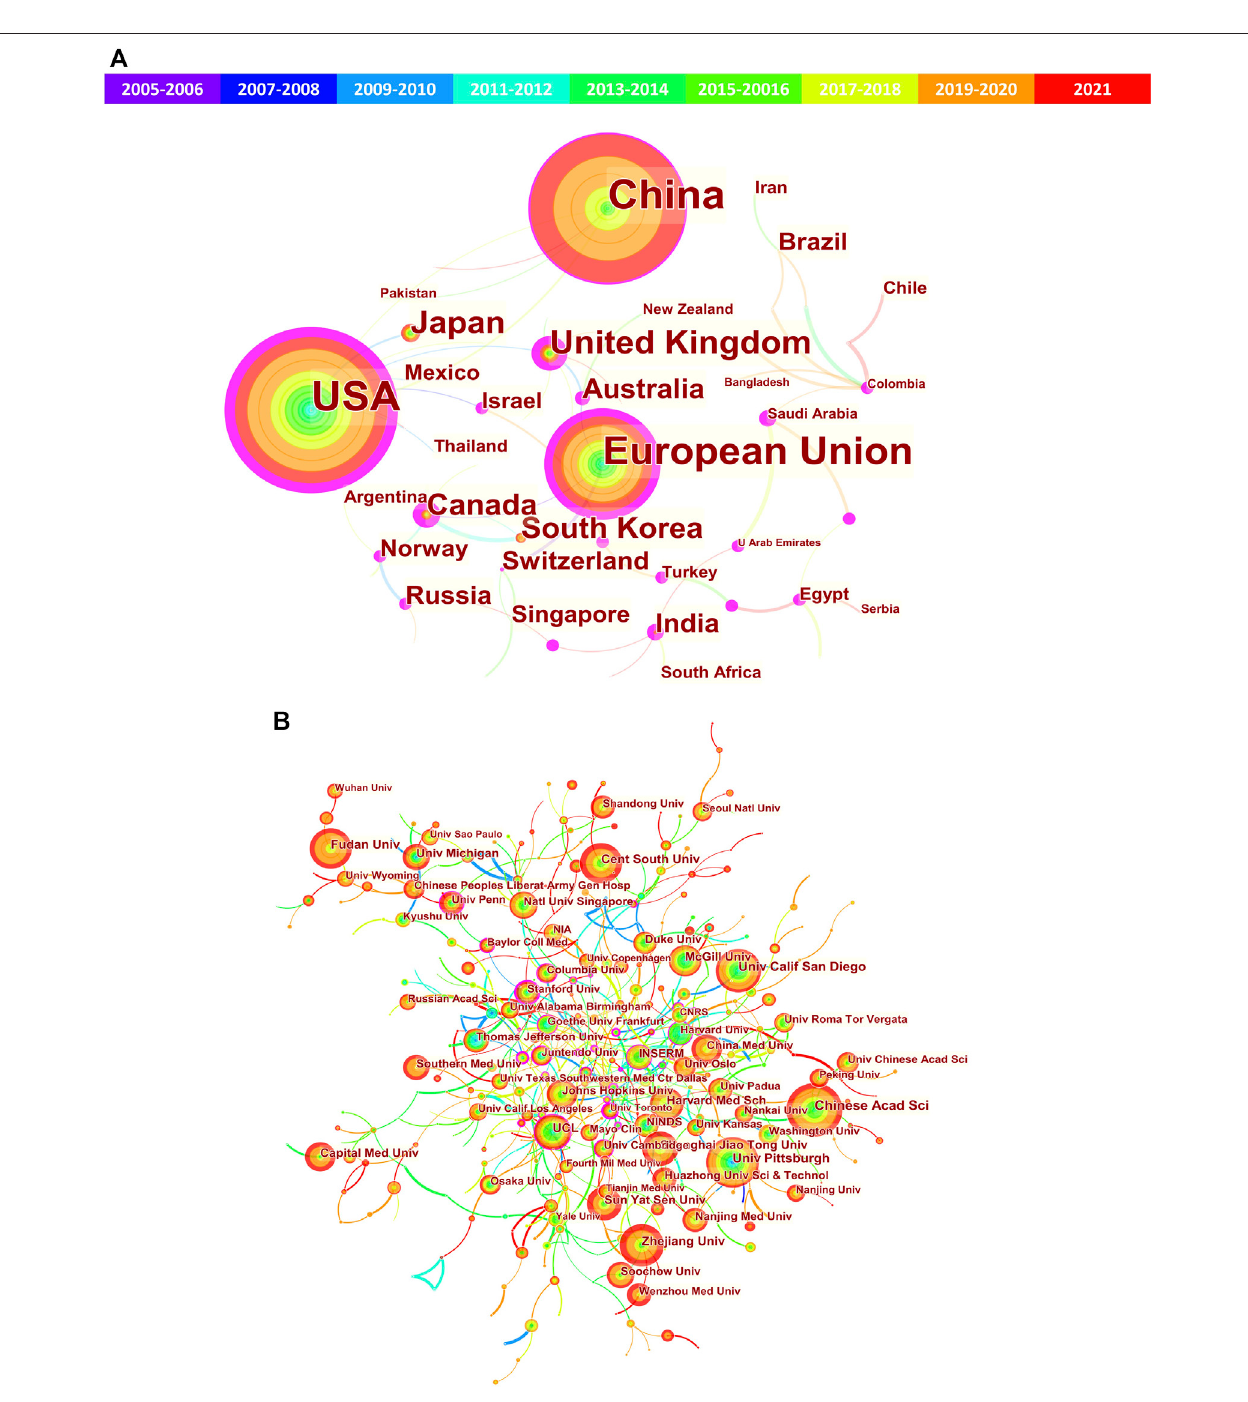
FIGURE 4 | Cooperation network of the countries/regions and institutions related to mitophagy. (A) Network map of countries/regions; (B) Network map of institutions. The nodes represent countries/regions or institutions (the larger circle, the higher the number of publications); lines between the nodes represent collaboration (the wider lines, the more frequency of collaborations); the purple ring represents active cooperation (centrality ≥ 0.10).